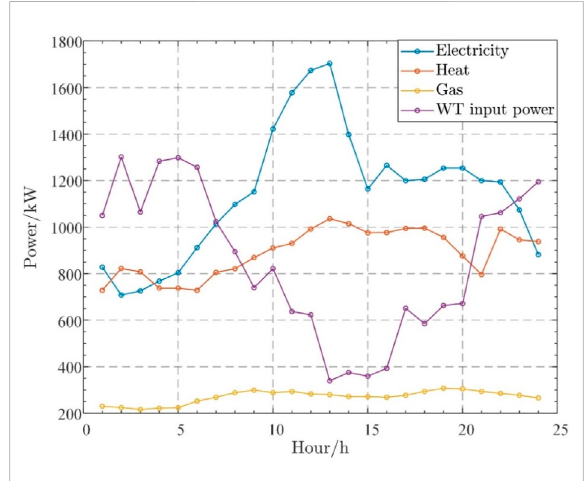
FIGURE 4 Pro fi lesoftheenergydemandsoftheIESandtheforecastWT input power.